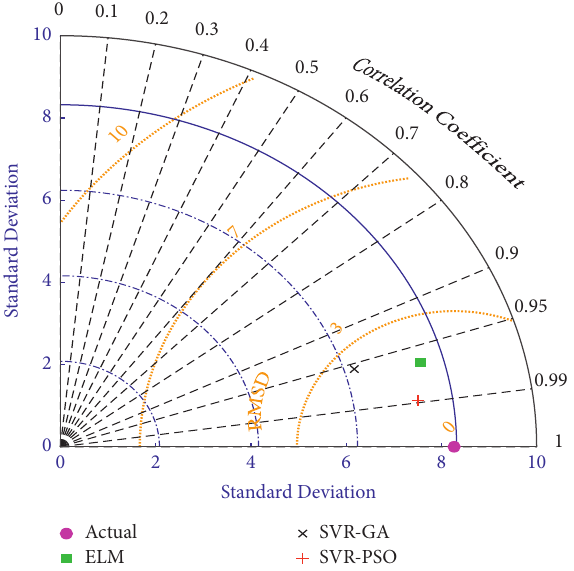
Figure 8: Taylor diagram for comparing the performances of the proposed models: testing set.